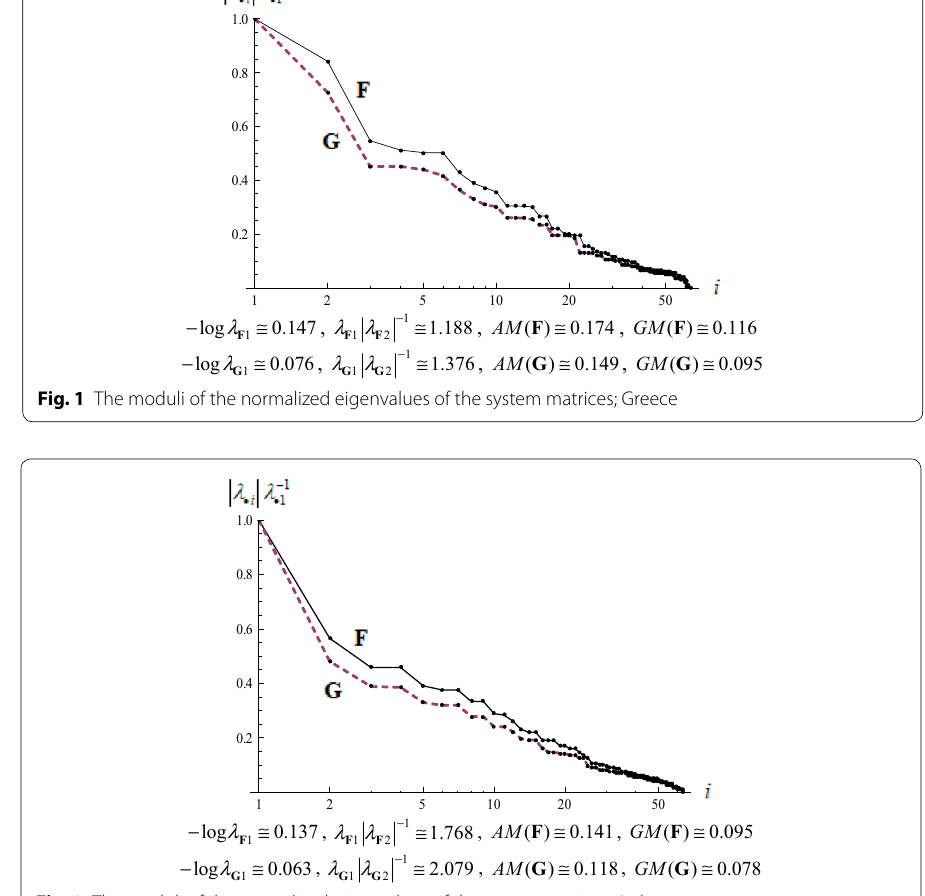
Fig. 2 The moduli of the normalized eigenvalues of the system matrices;